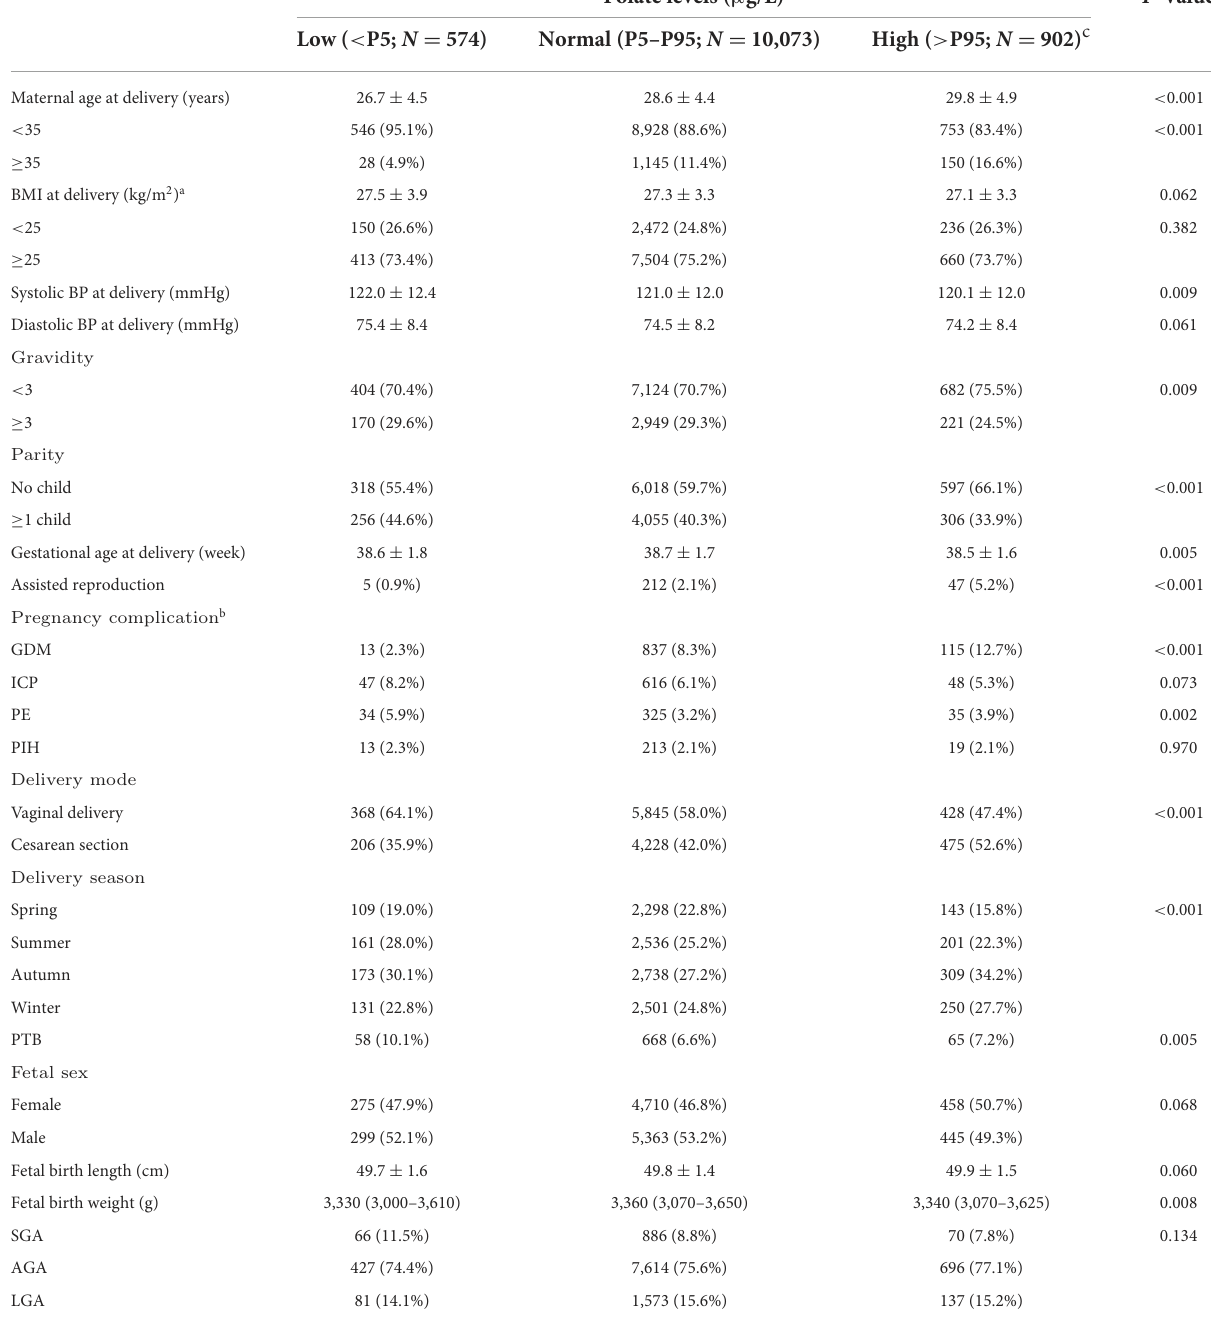
TABLE 3 Characteristics of study populations according to the categories of maternal serum folate levels during late